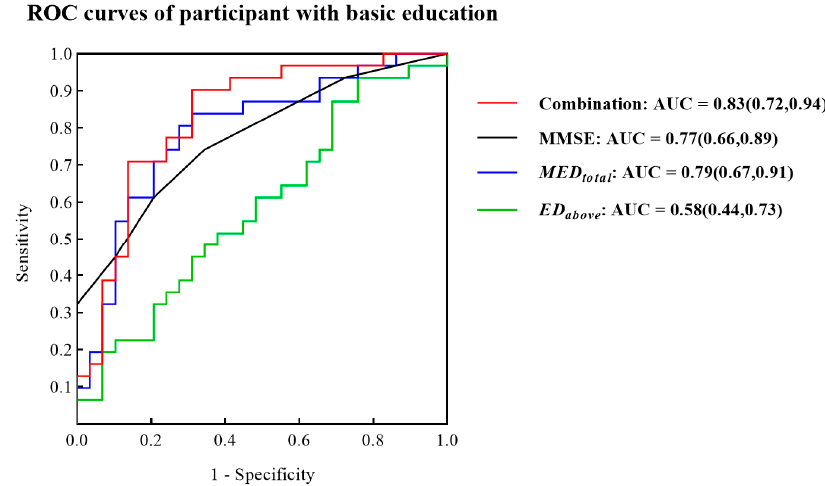
Figure 7. ROC curves of MMSE, MED total , ED above and the combination of MED total and ED above for the NC and MCI groups with basic education.